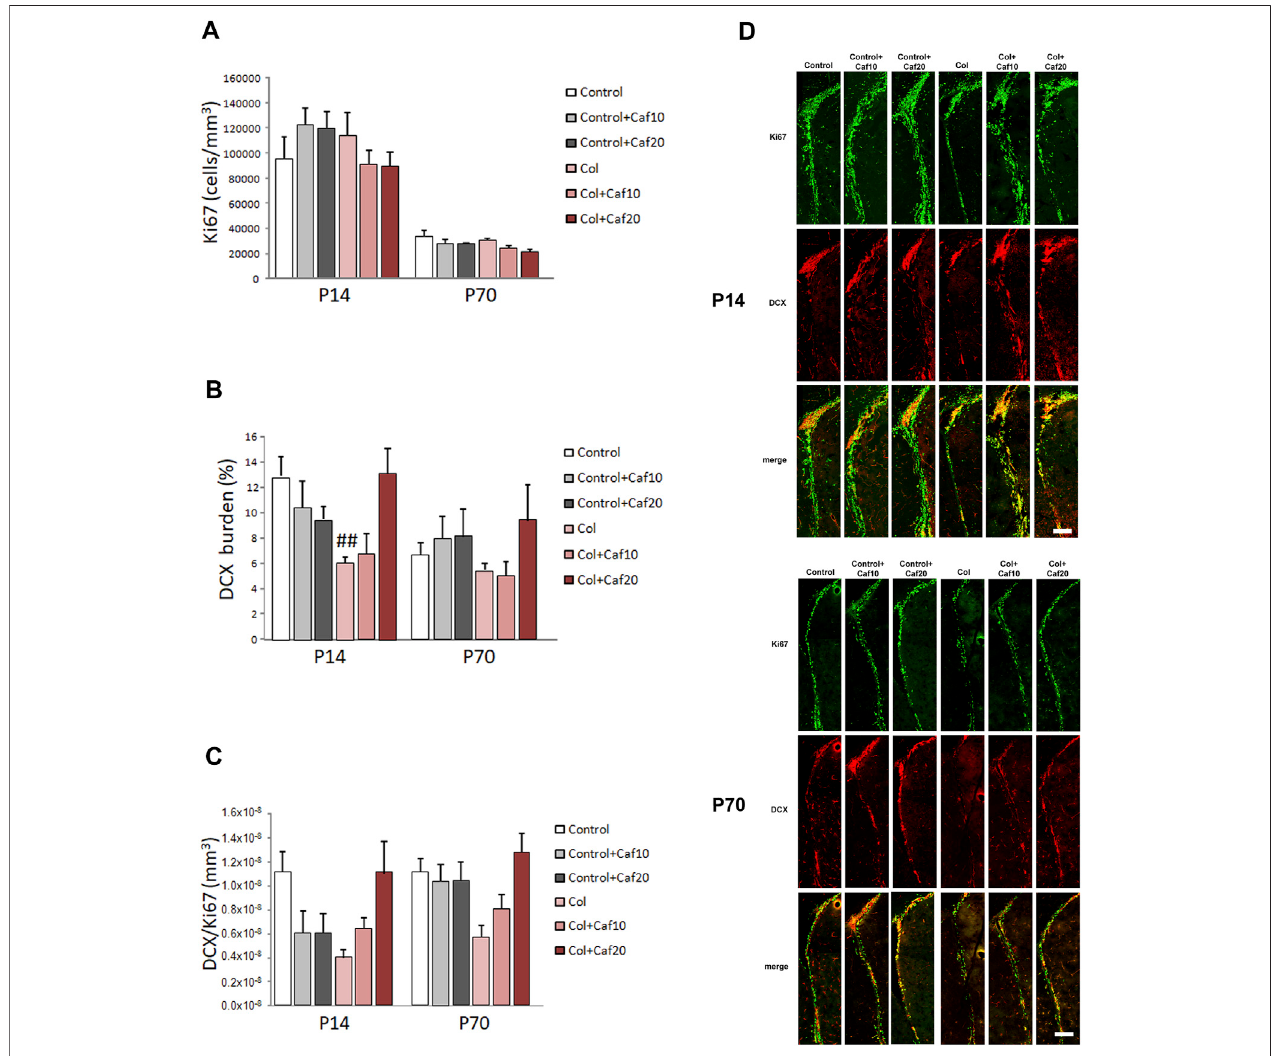
FIGURE 4 | Caf treatment improves neurogenesis in the SVZ after GM-IVH. (A) Proliferating cells were not signi fi cantly affected in the SVZ when we analyzed the densityofKi67 + cellsintheshort(P14)[F (2,94) =1.74and p =0.181]orthelong(P70)[F (2,85) =0.023and p =0.977]term. (B) DCXburdenwassigni fi cantlyreducedinthe SVZafterGM-IVHinduction.ThehighestdoseofCol(20 mg/kg/day) counterbalancedthissituationatP14[F (2,95) =5.86and p =0.003;## p =0.004vs.Controland col +Caf20],andasimilarpro fi lewasobservedatP70,althoughdifferenceswerenotstatisticallysigni fi cant[F (2,83) =0.694and p =0.503]. (C) DCXarea/Ki67 + cellratio was also reduced after Col lesions, although differences were not statistically signi fi cant at P14 [F (2,96) = 0.00 and p = 1.00] or P70 [F (2,84) = 0.00 and p = 1.00]. Data are representative of 6 – 7 animals (P14: Control n = 7, Control + Caf10 n = 6, Control + Caf20 n = 6, Col n = 7, Col + Caf10 n = 6, and Col + Caf20 n = 6. P70: Control n = 7, Control+Caf10n=6,Control+Caf20n=6,Coln=7,Col+Caf10n=6,andCol+Caf20n=6). (D) IllustrativeexampleofKi67(green)andDCX(red)immunostainingin the SVZ from mice with GM-IHV treated with Caf at P14 and P70. Scale bar = 125 µm.